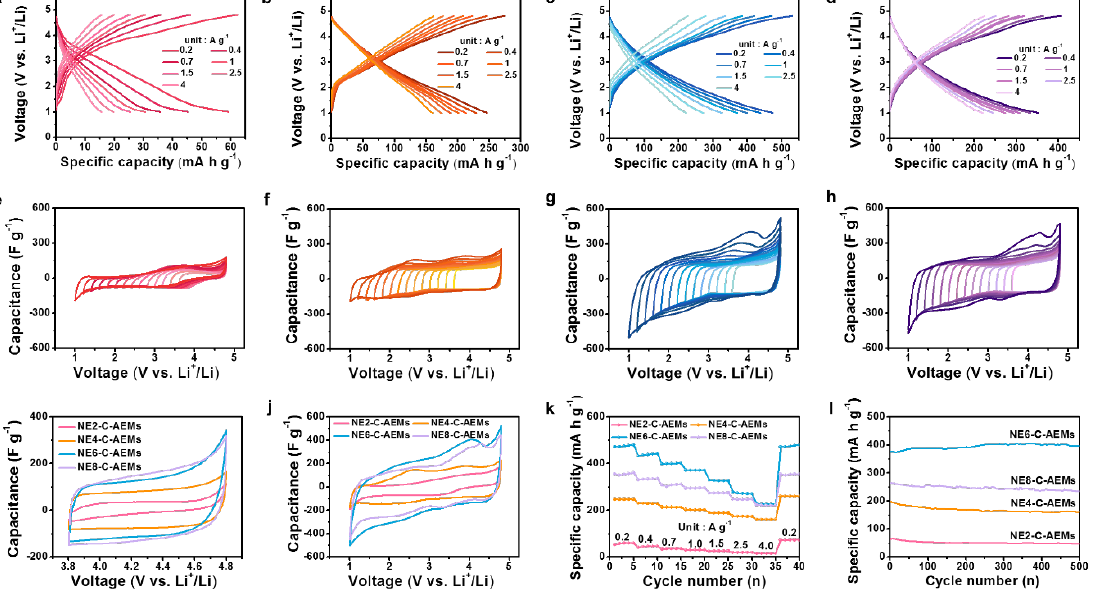
Figure 4. Electrochemical properties of the NE-C-AEMs in an electrolyte of 1 M LiPF6 dissolved in an EC/DMC mixture solution (1:1 v/v) as a positive electrode for LIBs. Galvanostatic charge/discharge profiles of ( a ) NE2-C-AEMs, ( b ) NE4-C-AEMs, ( c ) NE6-C-AEMs, and ( d ) NE8-C-AEMs. CV curves of ( e ) NE2-C-AEMs, ( f ) NE4-C-AEMs, ( g ) NE6-C-AEMs, and ( h ) NE8-C-AEMs in di ff erent voltage ranges. CV curves of NE-C-AEMs voltage ranges of ( i ) 3.8~4.8 V and ( j ) 1.0~4.8 V. ( k ) Rate